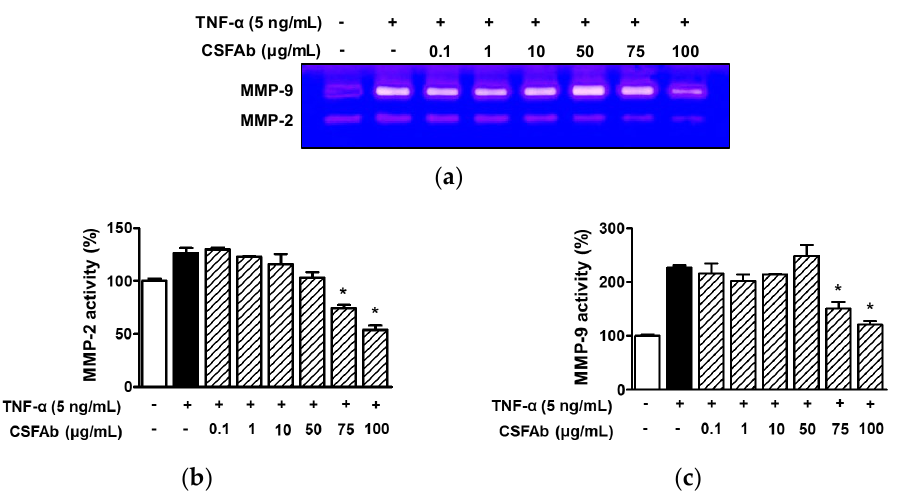
Figure 5. Effect of Caragana sinica flower absolute on MMP-9 and MMP-2 activities in HaCaTs exposed to TNF- α. ( a ) Representative image of zymography results. Cells were incubated with or without CSFAb (0.1–100 μg/mL) in the presence or absence of TNF- α (5 ng/mL) for 12 h. Conditioned media were subjected to a gelatin zymography assay to analyze MMP-9 and MMP-2 activities. ( b , c ) Statistical graphs of MMP-2 (( b ) n = 2) and MMP-9 (( c ) n = 2) and levels are shown in panel ( a ). Data are expressed as percentages of cells in the quiescent state. * p < 0.05 vs. the quiescent state. Low ECM collagen levels are closely associated with wrinkle formation in aged skin [39], and ECM collagens are degraded by MMPs. MMP-2 and MMP-9 can impair base-